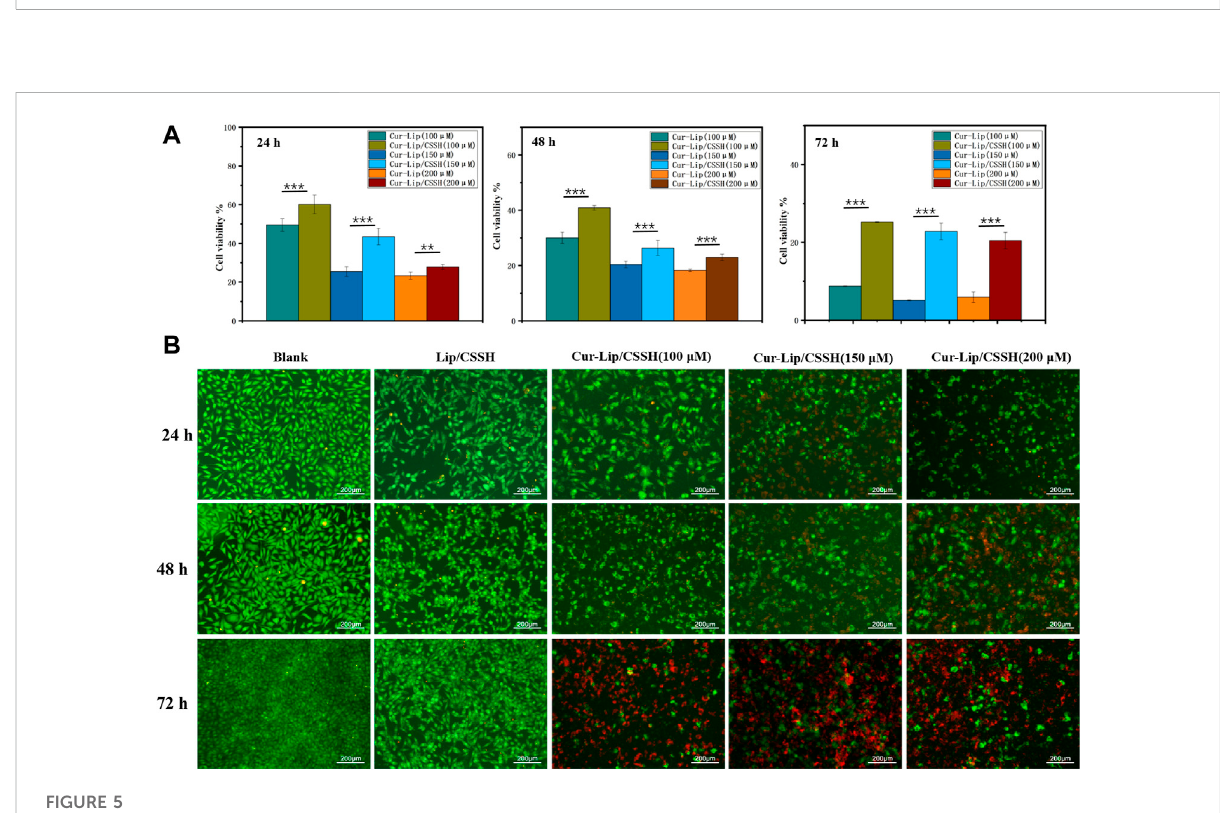
FIGURE 5 Cell proliferation (A) and AO/BE staining image (B)